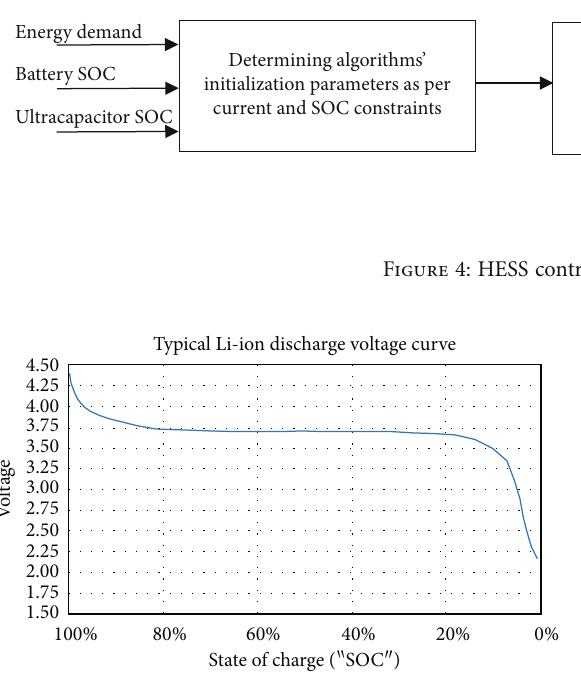
Algorithmic optimization for energy distribution presenting